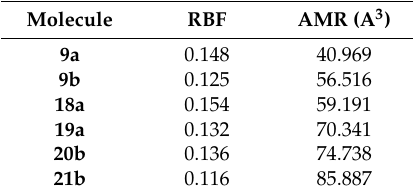
Table 2. Values of the flexibility and molecular volume descriptors of the GABA analogues.